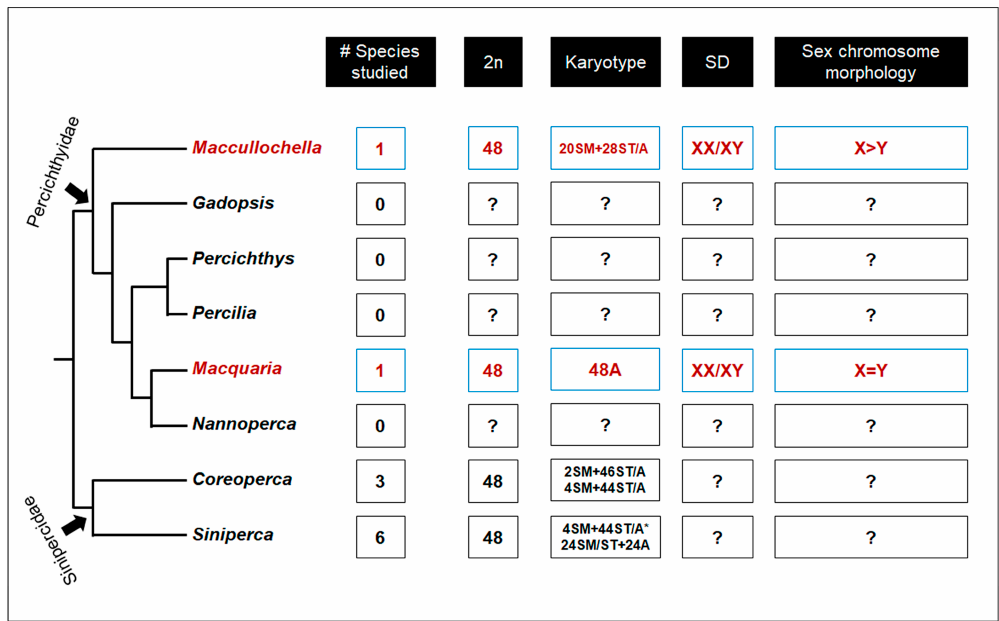
Figure 5. Truncated phylogenetic tree of the family Percichthyidae and sister clade from family Sinipercidae. Three monotypic genus, Bostockia , Guyu and Nannatherina were excluded due to unresolved phylogenetic position. Truncated phylogeny based on 10 nuclear genes was adopted from Near, et al . [29]. Red colour represents information derived from the present study. Phylogeny is not to scale. Asterisk (*) in Siniperca genus indicates most frequently observed karyotype [24]. The analysis of patterns of heterochromatin distribution is a useful tool for investigating karyotype diversification in vertebrate species. Within vertebrates, fish tend to lose substantial heterochromatin in their genomes [30]. Our C-banding identified significant C-bands near the centromeric region of the karyotype in both species. There were obvious differences in C-banding patterns in the Murray cod karyotype compared with that of the golden perch. Furthermore, within